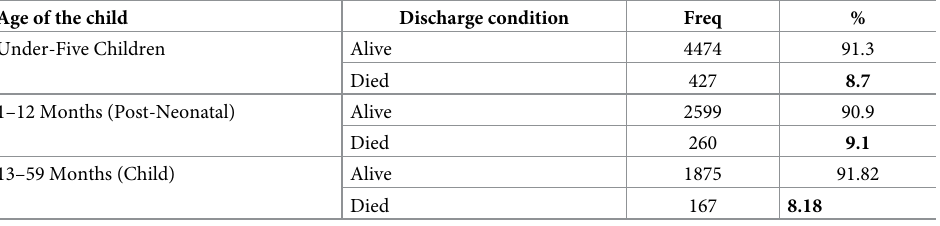
(Other medical conditions included are Alcohol Intoxication, Animal Bite, Arthritis, Chicken Pox, Hypertension, Hydrocele, Hypoglycemia, Mumps, Osteomyelitis, Otitis Media, Poisoning, Poliomyelitis, Rabies, Rectal Prolapse, Rickets, RVI, Sexual Assault and Acute Viral Hepatitis AND cases included under Surgical conditions are abscess, acute abdomen, burn, cellulitis, trauma, hernia, hydrocele, animal bite and rectal prolapse). associated factors for under-five, child and post-neonatal mortality in Asella teaching and referral hospital, southeastern Ethiopia. The study revealed the prevalence of 8.7% (87/1000) (95% CI, 7.91%-9.50%) under-five mortality. Post-neonatal and child mortality rates were 9.1% (91/1000) and 8.18% (81.8/1000), respectively. Place of residence, HIV status, severe acute malnutrition, hypovolemic shock, type I diabetes with DKA and length of stay in the hospital for � 2 days and 3–4 days were among the identified predictors. Table 3. Under-five, post-neonatal and child mortality among children admitted to pediatrics ward of Asella Teaching and Referral Hospital, January 2020 G.C. Age of the child